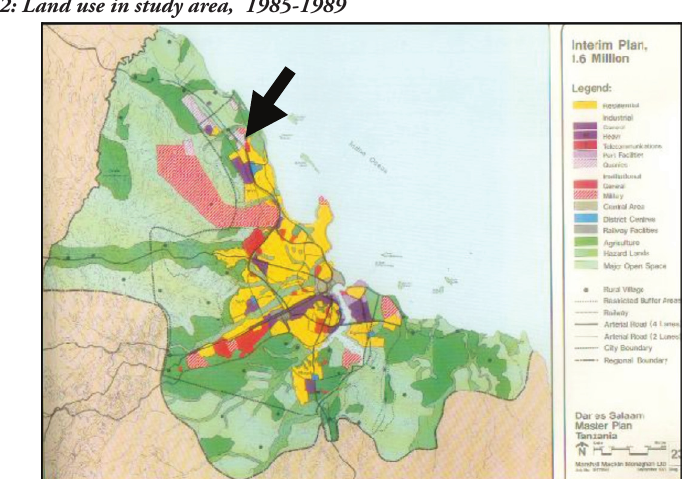
Figure 2: Land use in study area,